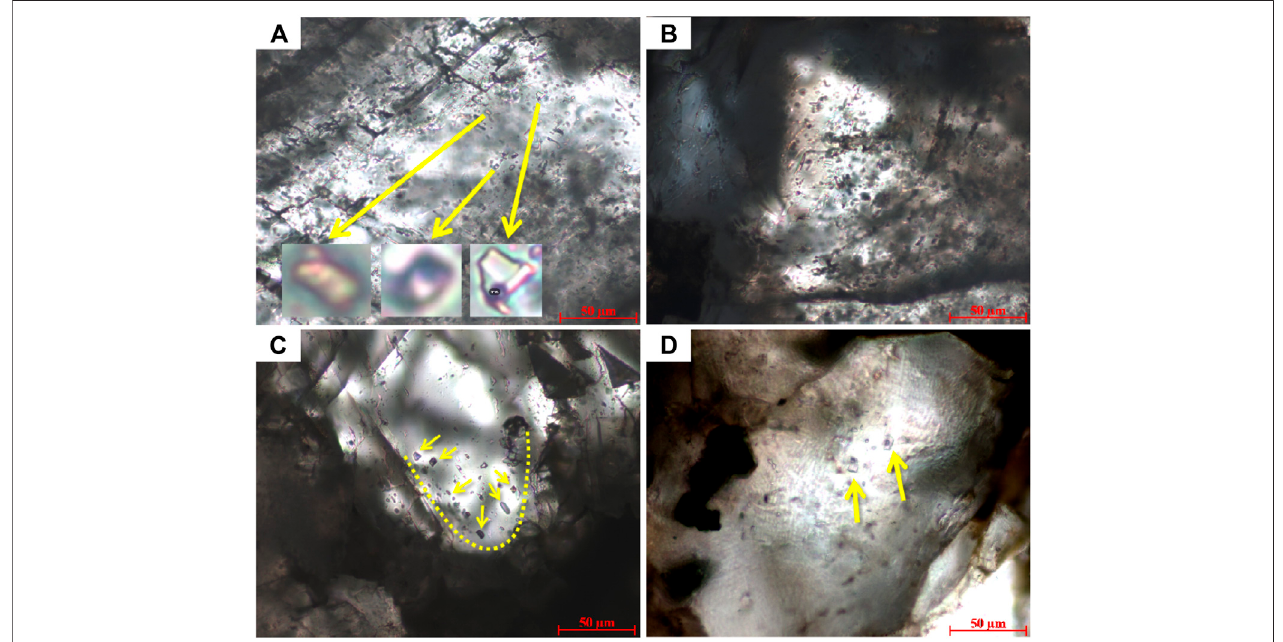
FIGURE 10 | Photomicrographs showing fl uid inclusion petrography. (A) Liquid-dominated fl uid inclusions were distributed along the edge of the crystal (Sample HS1-4966); (B) liquid-dominated fl uid inclusions in random populations were distributed evenly in a crystal without special orientation (Sample K2-2432.4); (C) liquid- dominated fl uid inclusions outlined the growth zone of Cd (Sample ZC-22b); (D) isolated fl uid inclusions in the limpid Cd crystal (Sample HJL-6C).